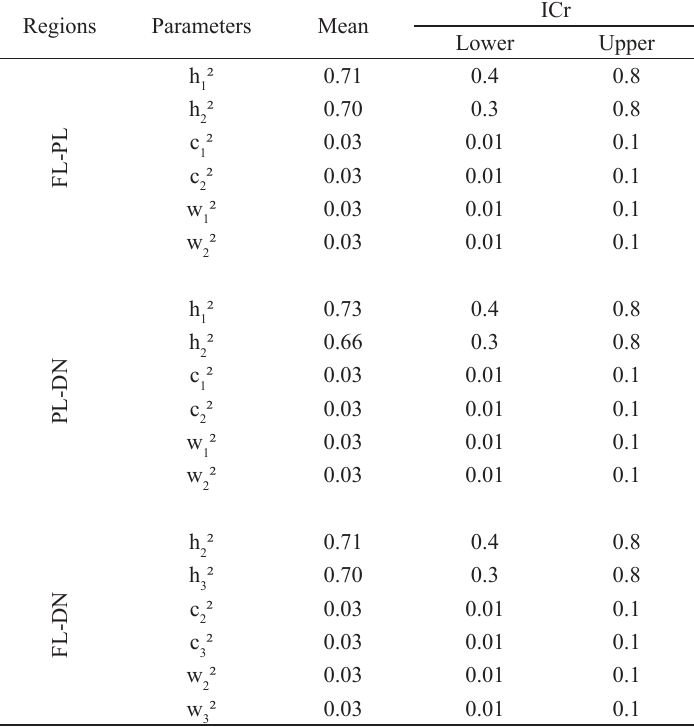
Estimates using the bi-characteristic